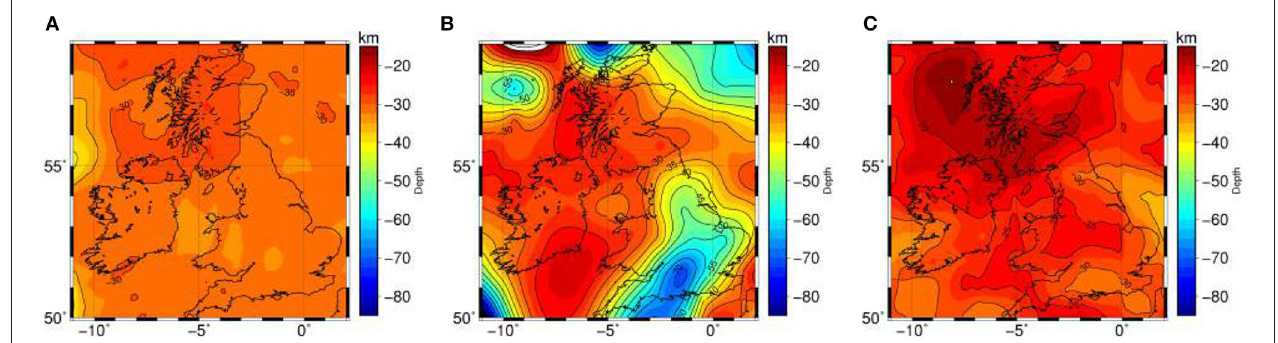
FIGURE 12 | Curie temperature depth maps. (A) Curie temperature depth from model M_1-s . (B) Curie temperature depth estimated from surface heat flow by Szwillus et al. (submitted). Reproduced from Szwillus et al. (submitted) by the permission of copyright holder [Szwillus W.]. (C) Curie temperature depth estimated from EMAG2. Reproduced from Li et al. (2017) by the permission of copyright holder [Li